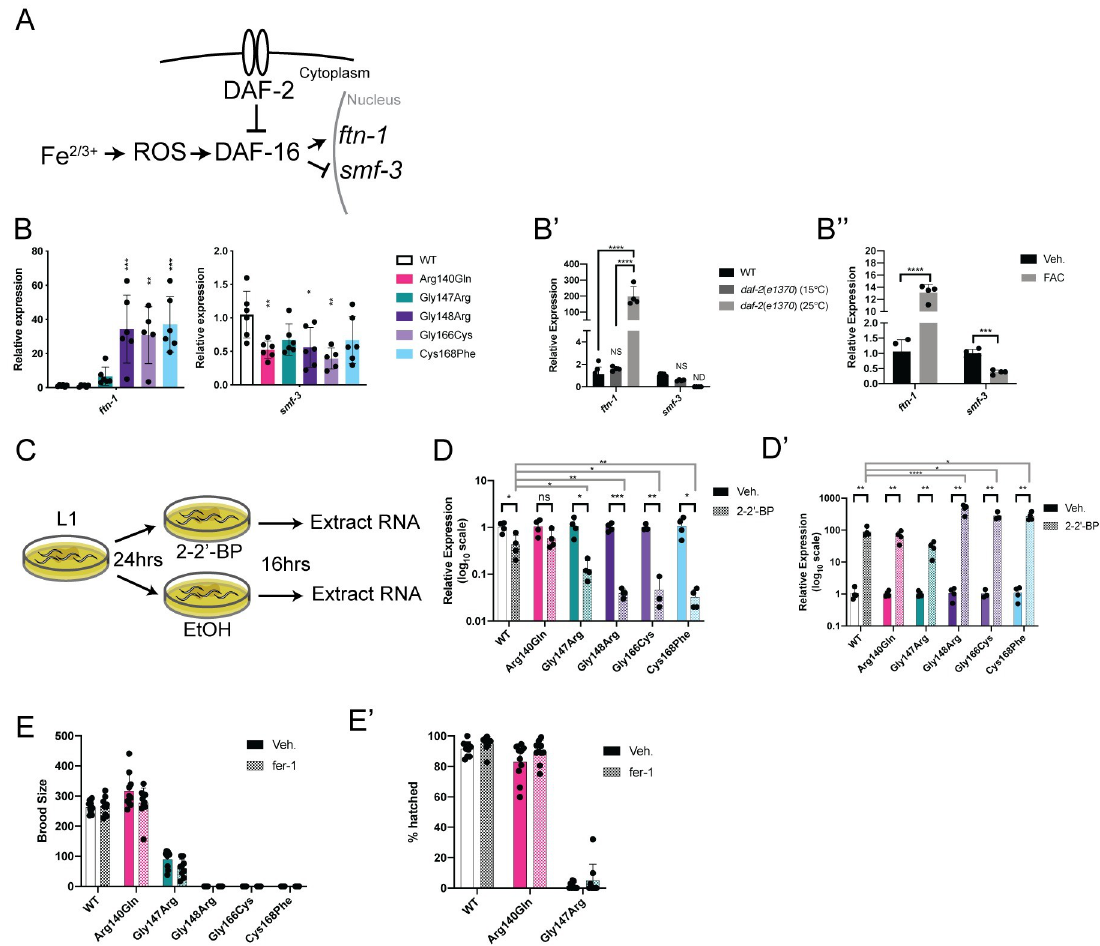
Fig 5. DAF-16-mediated iron response activation in nfu-1 mutants. (A) Schematic of the DAF-16-mediated iron response pathway. DAF-16 is normally inhibited (indirectly) by DAF-2. Upon disinhibition, DAF-16 translocates to the nucleus where it can activate its transcriptional program including the C . elegans iron response. (B-B”) Gene expression of ftn- 1 and smf-3 (n = 3–6). (B) WT and nfu-1 mutants; (B’) WT and daf-2(e1370) at 15˚C or 25˚C; (B”) Veh. (H 2 O) or FAC treatment. (C): Schematic of 2–2’-BP treatment. (D-D’) Gene expression of ftn-1 and smf-3 following treatment with Veh. (EtOH) or 2–2’-BP (n = 3–5). (D) Expression of ftn-1 ; (D’) Expression of smf-3 . (E-E’) Fecundity assays following treatment with Veh. (DMSO) or fer-1 (n = 9–10). (E) Total brood size. (E’) Embryonic viability. B-B”: � : p � 0.05; �� :p � 0.01; ��� :p � 0.001; ���� :p � 0.0001 difference between (B) WT and nfu-1 mutants by One-way ANOVA with Dunnett correction for multiple comparisons; (B’) all groups by One-way ANOVA with Tukey correction for multiple comparisons; or (B”) Vehicle and FAC by parallel two-tailed Student’s T-test with Holm-Sidak correction for multiple comparisons. D-D’ black bars: � : p � 0.05; �� :p � 0.01; ��� :p � 0.001 between Veh. and 2–2’-BP by parallel two-tailed Student’s T-test with Holm-Sidak correction for multiple comparisons. D-D’ gray bars: � : p � 0.05; �� :p � 0.01; ���� :p � 0.0001 between fold change of WT and fold change of nfu-1 mutants as post- hoc One-way ANOVA with Dunnet correction for multiple comparisons. ROS: reactive oxygen species;: Veh.: Vehicle; FAC: ferric ammonium citrate; 2–2’-BP: 2–2’-bipyridyl; ND: Not detected; NS: Not